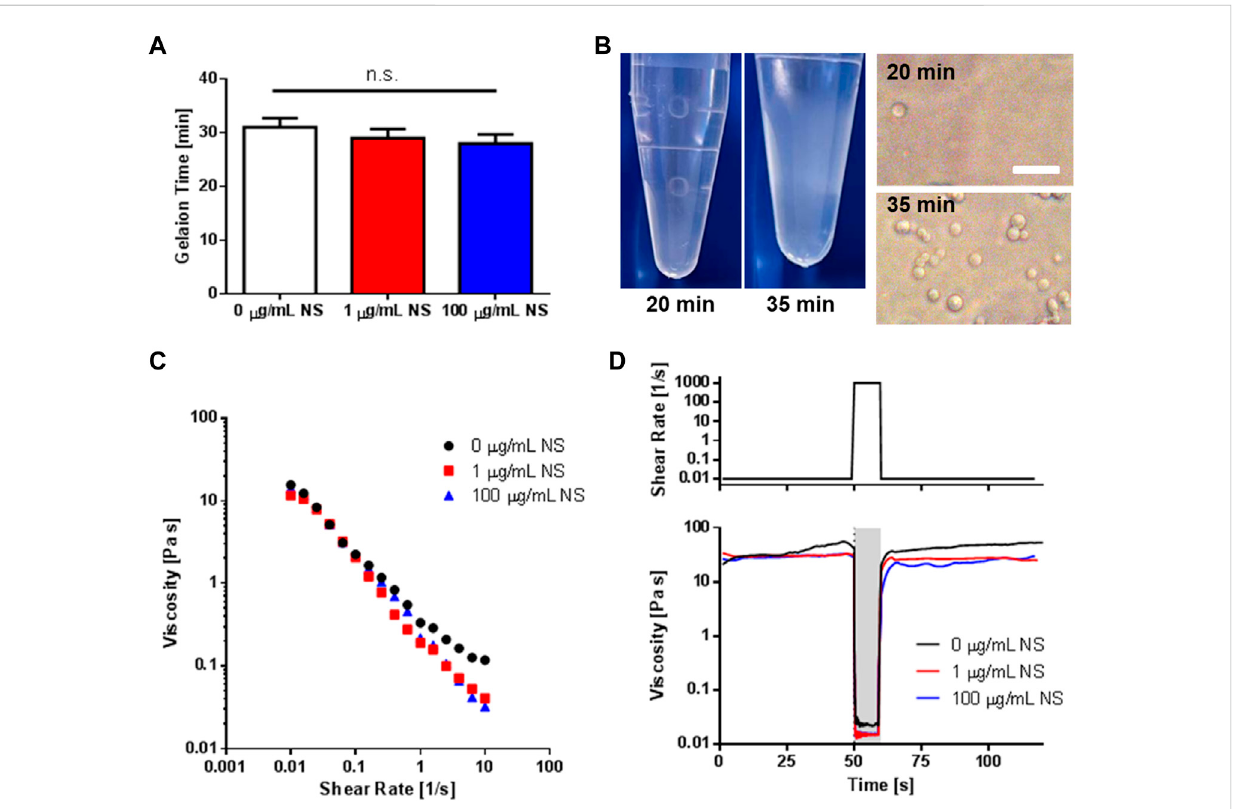
FIGURE 5 Gelation Time and Injectability of PEG-NS Microspheres. (A) Gelation time of microspheres as a function of NS concentration as determined from imaging as shown in (B) . (B) Representative macro and microscopy images showing the presence of PEG-rich droplets prior to gelation (20 min) and following gelation (35 min) for 100 μ g/mL NSsamples. Images of were taken following buffer exchange into PBS. Scale bar represents 20 μ m. (C) Shear- thinning behavior of microspheres in the absence and presence of NS. (D) A representative rheological simulation of shear stresses encountered duringextrusionfromaninsulinneedle.Aperiodoflowshearratewasfollowedby10 sofhighshearrate(simulatingextrusion),whichwasthenfollowed byanotherperiodoflowshearrate.Microspheresfabricated with0,1,or100 μ g/mLNSregainedtheirinitialviscosities,indicating hydrogelstructurewas not adversely